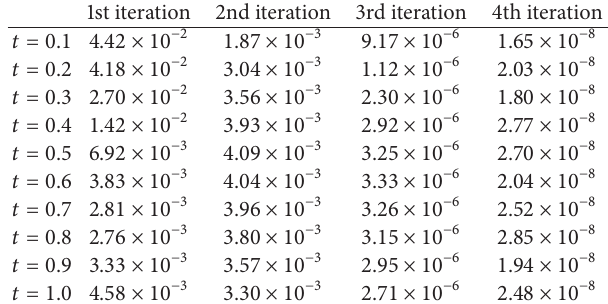
Table 2: Comparison of absolute error of Example 2 obtained with the proposed method and its comparison with RKM [30] and improved reproducing kernel method [29].